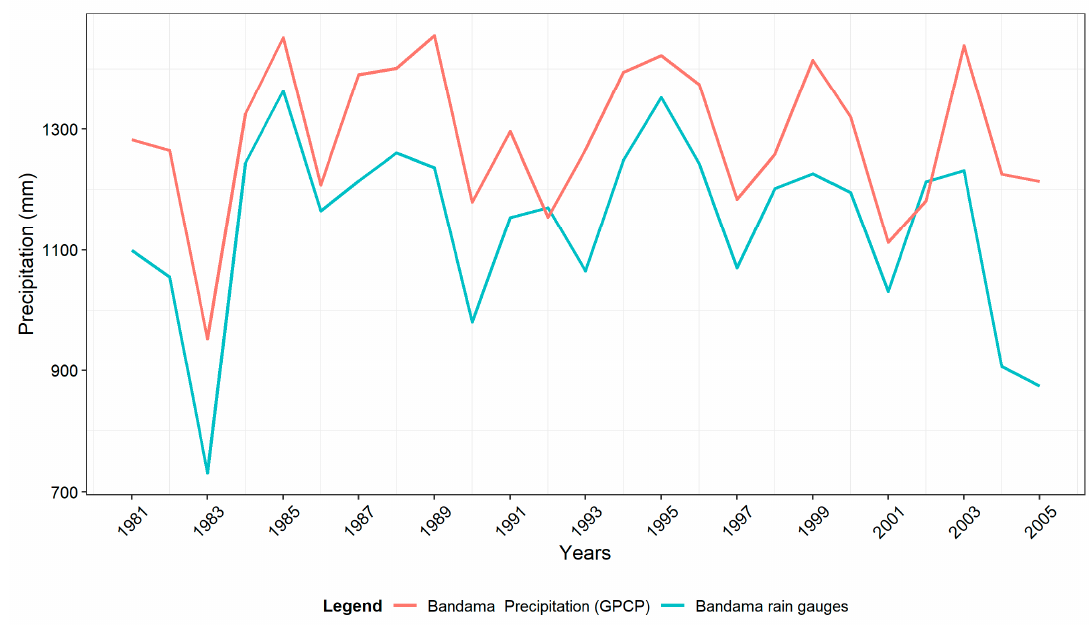
Figure 2. Comparison of observed rainfall (rain gauges) and GPCP precipitation over Bandama basin for the 1981–2014 period.